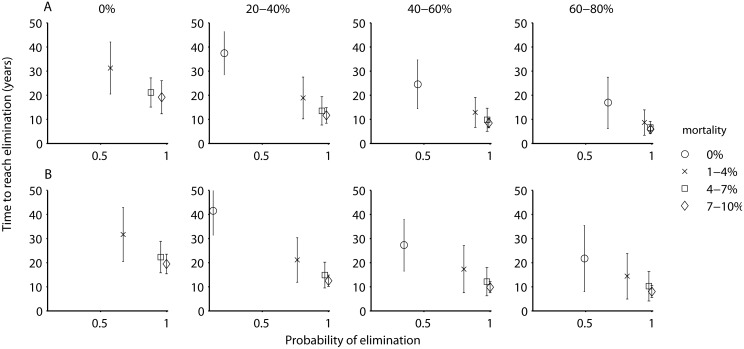
The proportion of simulations where HAT was eliminated (prevalence < 1 x 10−6) and the mean time to elimination with standard deviation, depending on the percentage of the human population screened per year (expressed as absent (0%), low (20–40%), moderate (40–60%), or high (60–80%) coverage and indicated by the plot titles), with varying levels of vector control (expressed as additional vector mortality, indicated by the symbols in the legend), for a high transmission setting without an animal reservoir (A) and with an animal reservoir (B).